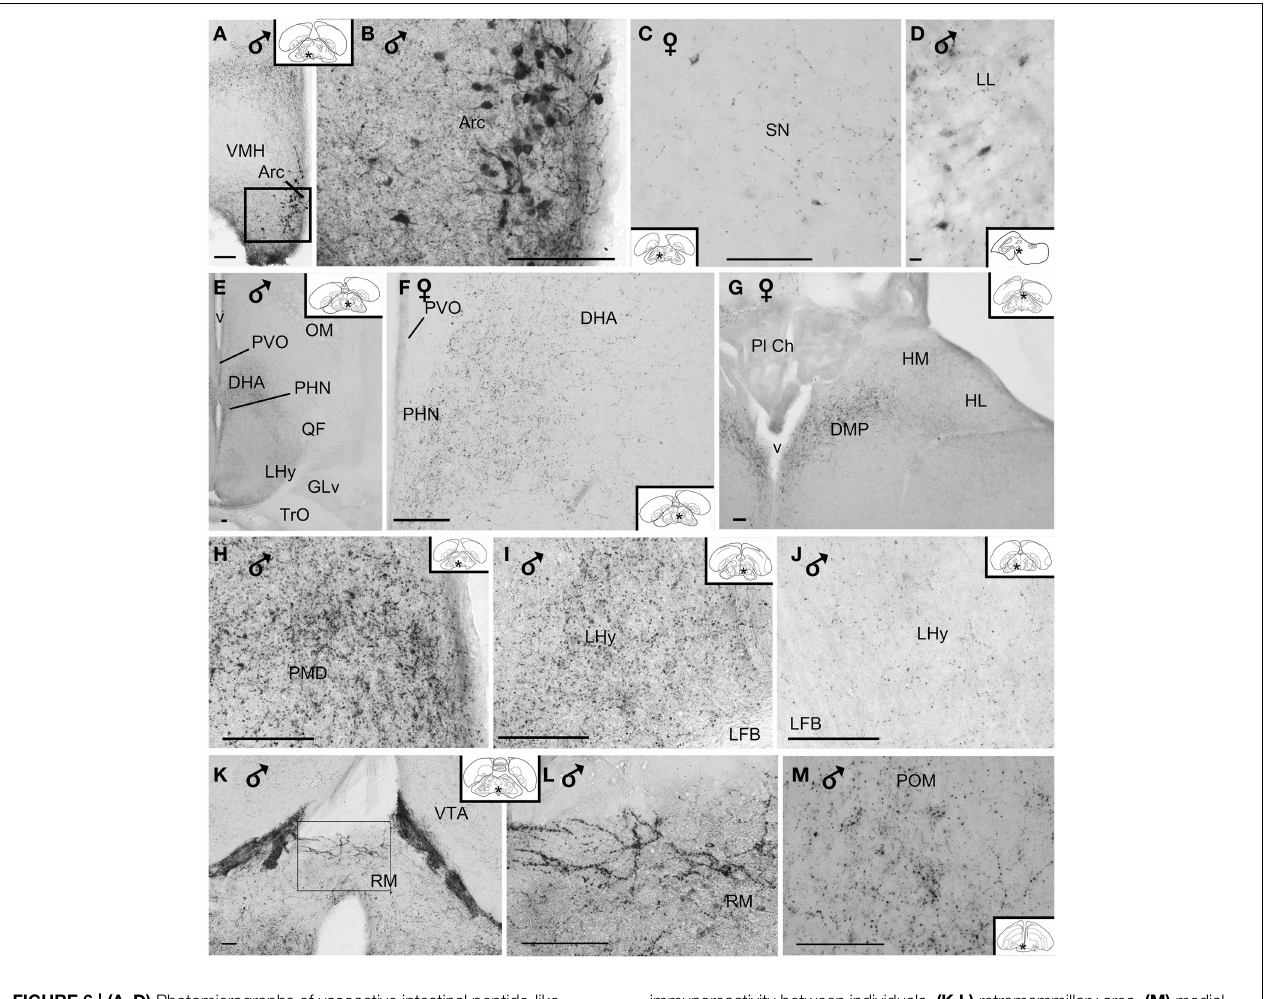
FIGURE 6 | (A–D) Photomicrographs of vasoactive intestinal peptide-like immunoreactive perikarya in the brain of blue tit: (A,B) arcuate nucleus, (C) substantia nigra, (D) lateral lemniscus. (E) Overview image of the hypothalamus. Fibers and terminal field (F) in the dorsal hypothalamic area, (G) posterior dorsomedial thalamus and habenular nuclei, (H) dorsal premammillary nucleus, (I,J) lateral hypothalamic area showing variability of